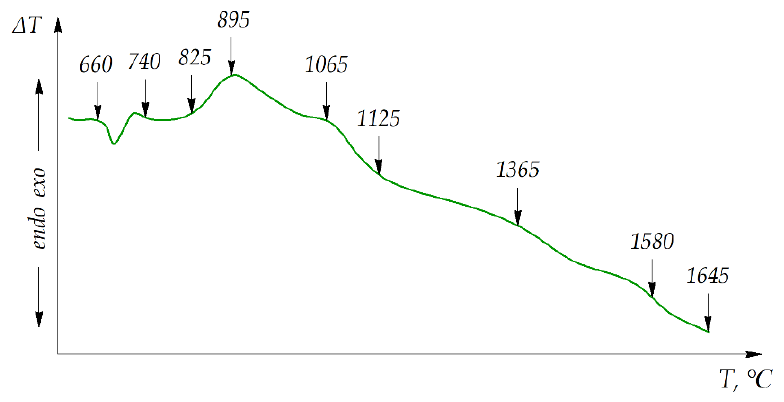
Figure 2. Thermogram of the initial powder mixture Cr 2 O 3 + 13 wt.%